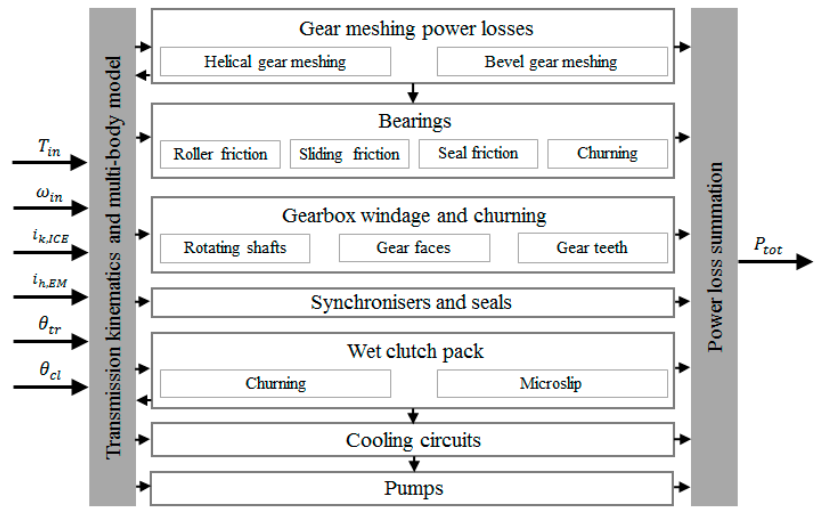
Figure 3. Transmission power loss model structure.